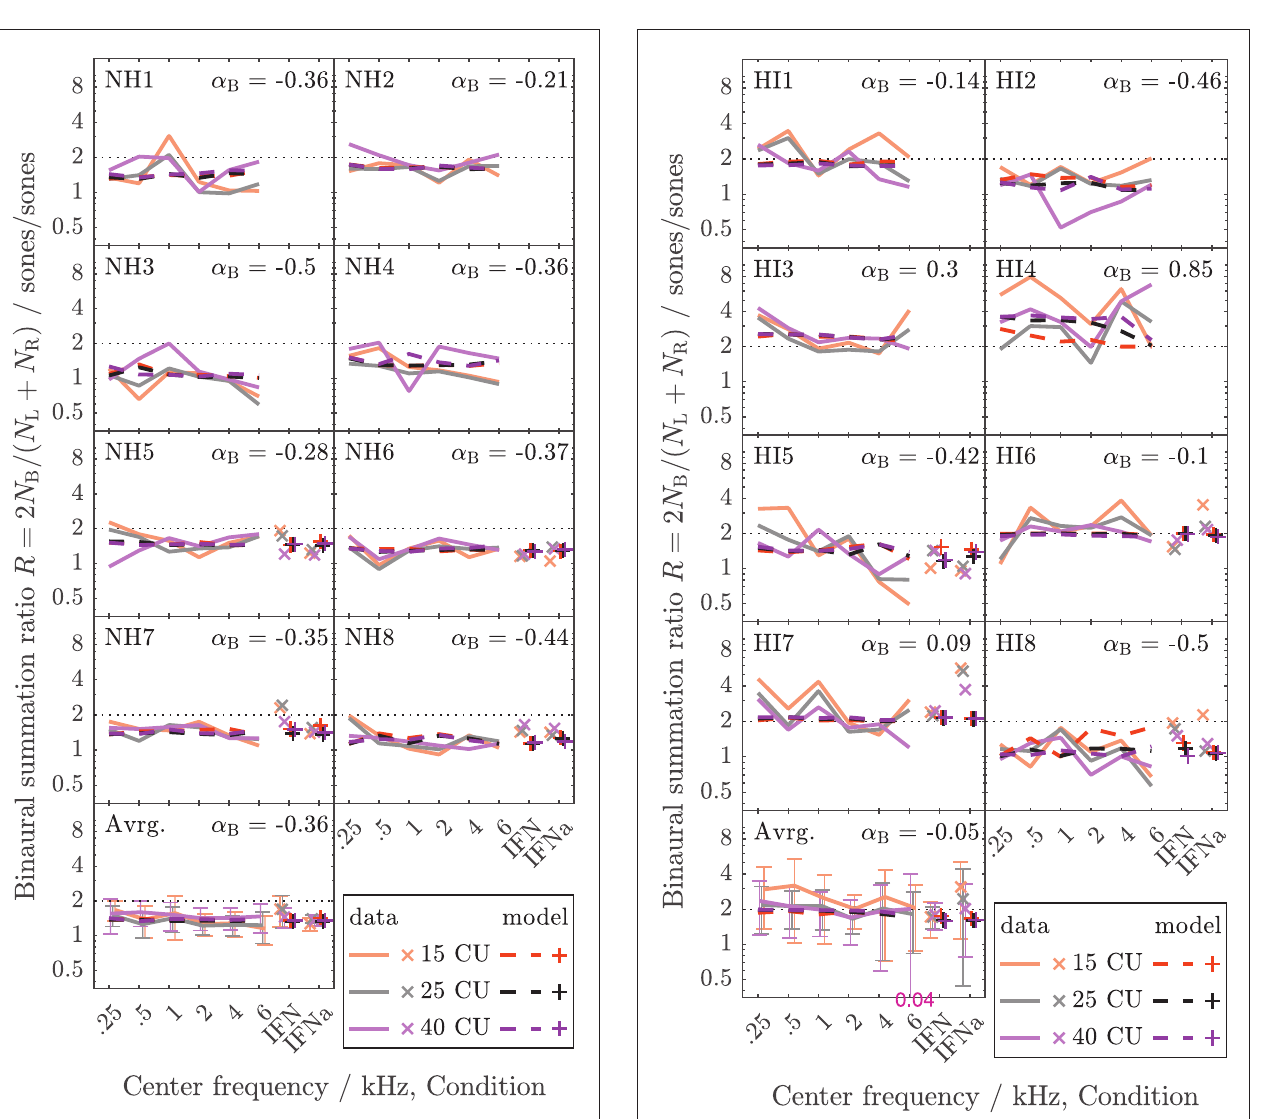
FIGURE 4 | As Figure 3 but for the HI listeners of Dataset 1. by the loudness of the diotically presented stimulus (orange: 15 CU, gray: 25 CU, purple: 40 CU), and therefore R also does not depend on the stimulus level, as previously found by Marozeau et al. (2006). In some of the NH listeners, some unsystematic variation of the ratios with the stimulus frequency is observed. HI listeners in Figure 4 vary considerably across listeners and within listeners across stimuli. The ratios for HI3, HI4, and HI7 are predominantly higher than 2, indicating binaural excitation. Occasionally, quite high ratios are observed for few frequencies and mostly low levels (and low loudness categories) close to the hearing threshold (maximum ratio R = 7.9 at 0.5 kHz, 15 CU for HI4). On average, across the listeners (bottom panels), the ratios of NH and HI decrease slightly with increasing